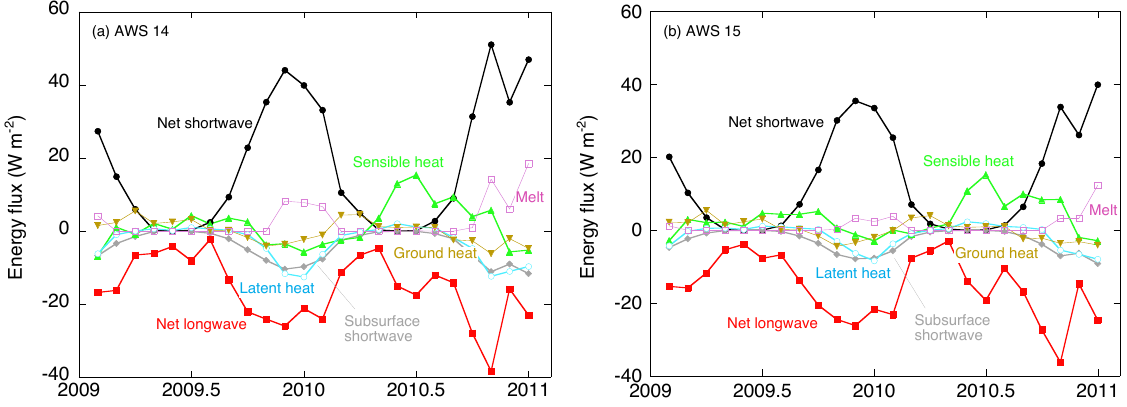
Fig. 7. Monthly means of surface energy budget components (in Wm − 2 ) for (a) AWS 14; and (b) AWS